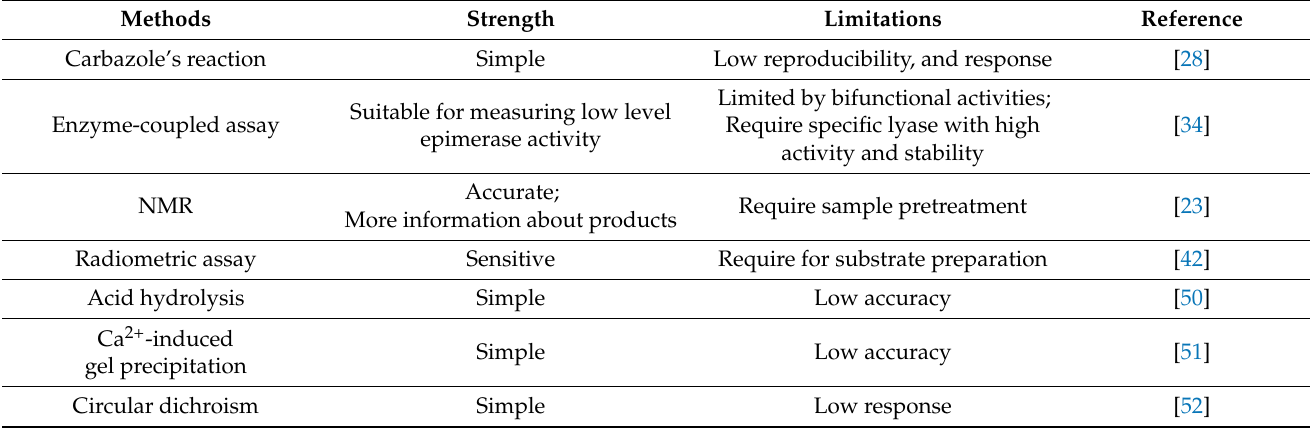
Table 1. Methods that applied for the determination of the epimerase activity of ManC5-Es, and their strength and